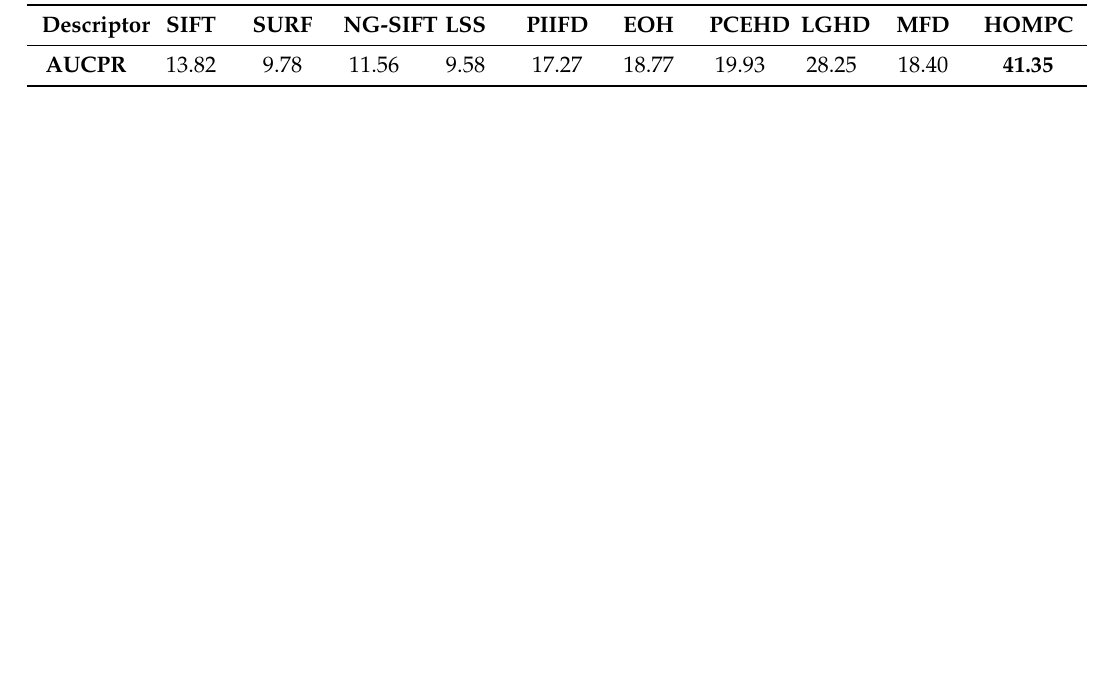
Table 5. AUCPR (%) results for all the